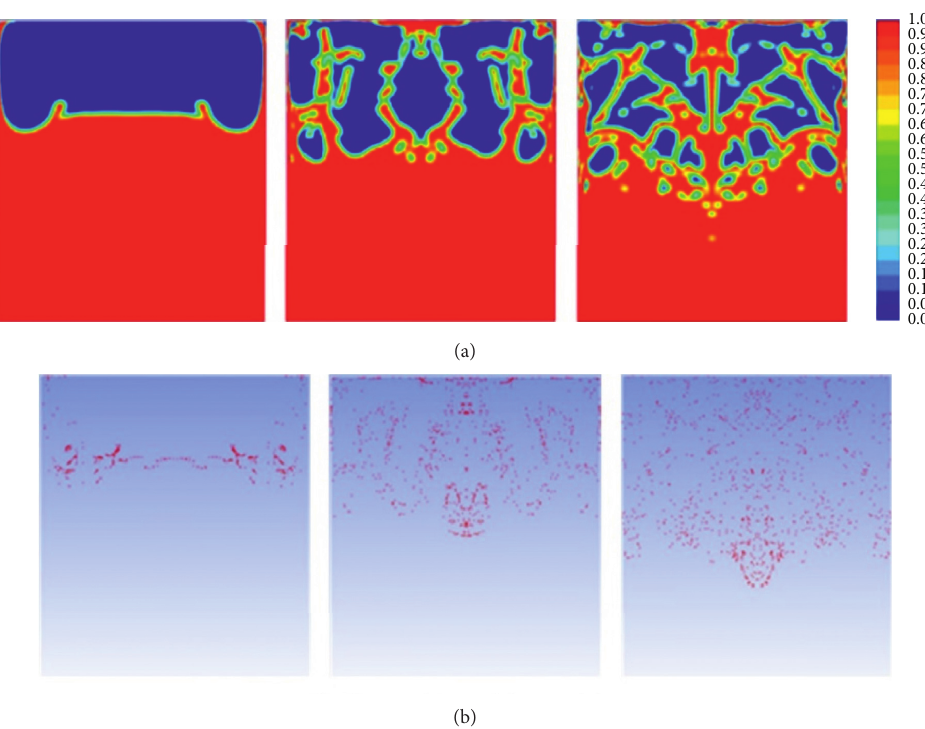
Figure 2: Numerical simulation result at t � 0.1s, 0.3s, and 0.5s, respectively. (a) The flow pattern. (b) The position of the